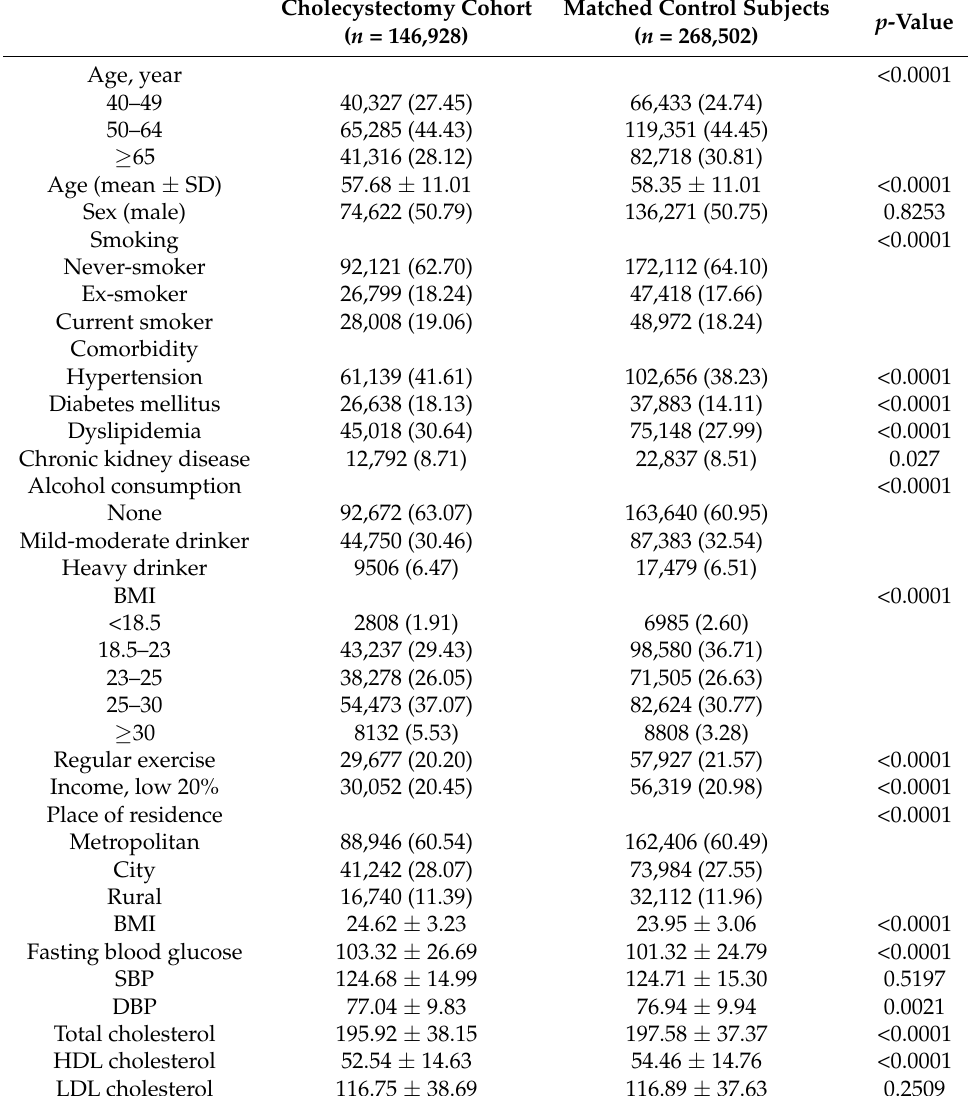
Table 1. Baseline characteristics of the matched